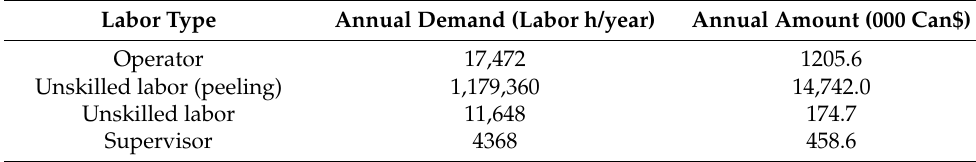
Table 5. Annual labor demand and cost for the puree production plant (base